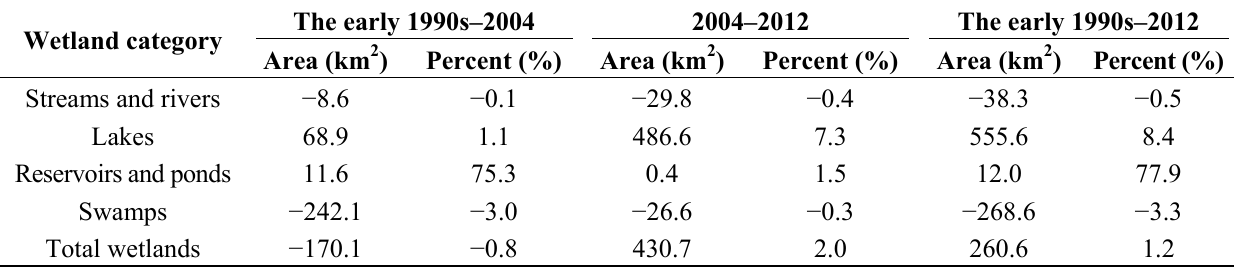
Table 3. The area changes of different wetland categories from the early 1990s to